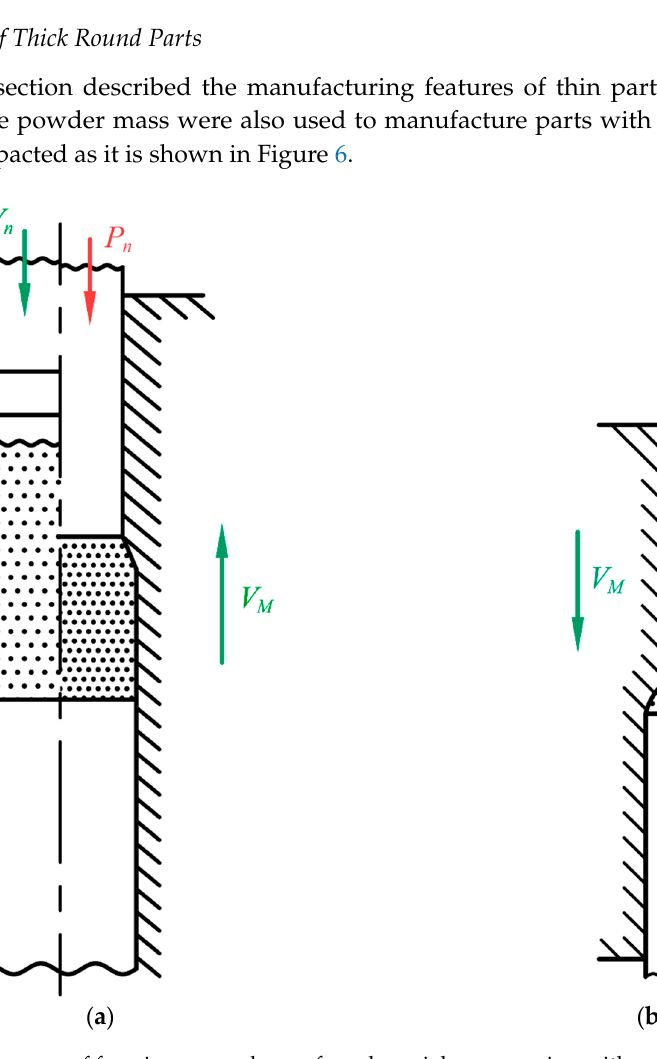
Figure 6. The sequence of forming a powder preform by axial compression with creation of a shift of powder particles: ( a ) Preform compaction with its simultaneous expansion from 36 mm- to 32 mm-cavity; ( b ) preform compressing from the 36 mm- to the 32 mm-cavity; V n is the direction of movement of the punch; V M is the direction of movement of the die; P n is the force applied to the punch.